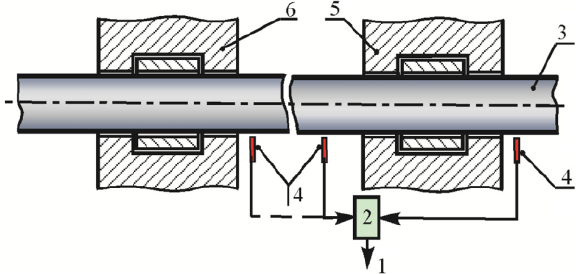
Figure 1. Rotating shaft vibration sensor mounted points: 1—fault diagnostic system with special processing tools, 2—data acquisition, 3—rotor shaft, 4—sensors, 5—housing, 6—bearing. processing tools, 2—data acquisition, 3—rotor shaft, 4—sensors, 5—housing,